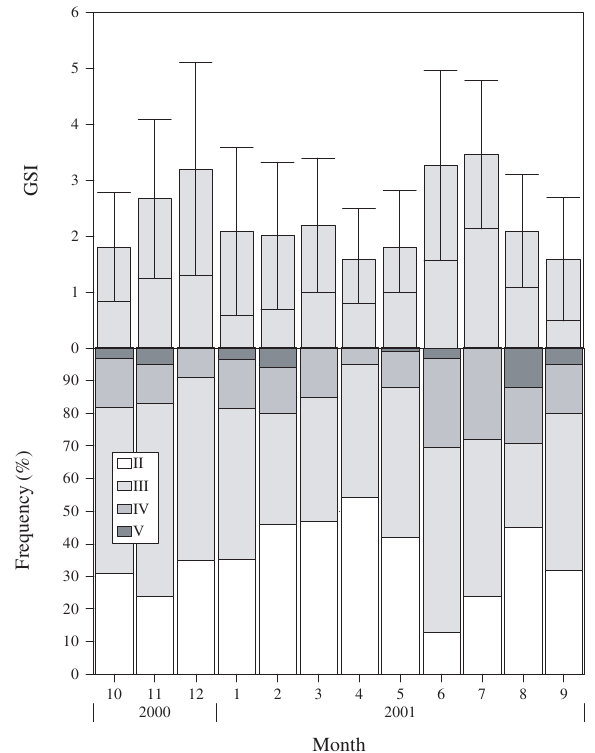
F IG . 2. – Mean monthly evolution (top) of the gonadosomatic index (GSI) and (bottom) maturity stages for all P. incisus collected off the Canary Islands.